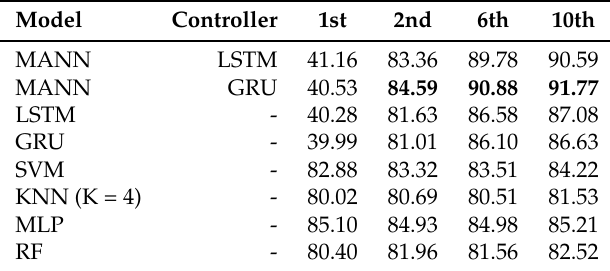
Table 5. In the case of fine-tuning, the previous model is continued to train with 11 samples each class of ransomware before classifying the remains ransomware samples in Domain 2